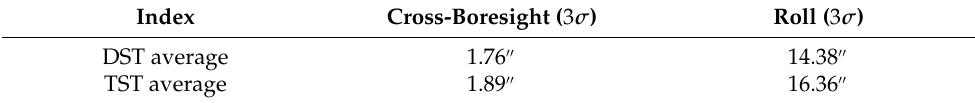
Figure 17. The variation of three-axis accuracy for two star trackers. Table 6. The cross-boresight and roll axis average accuracy (3 σ ) for two star